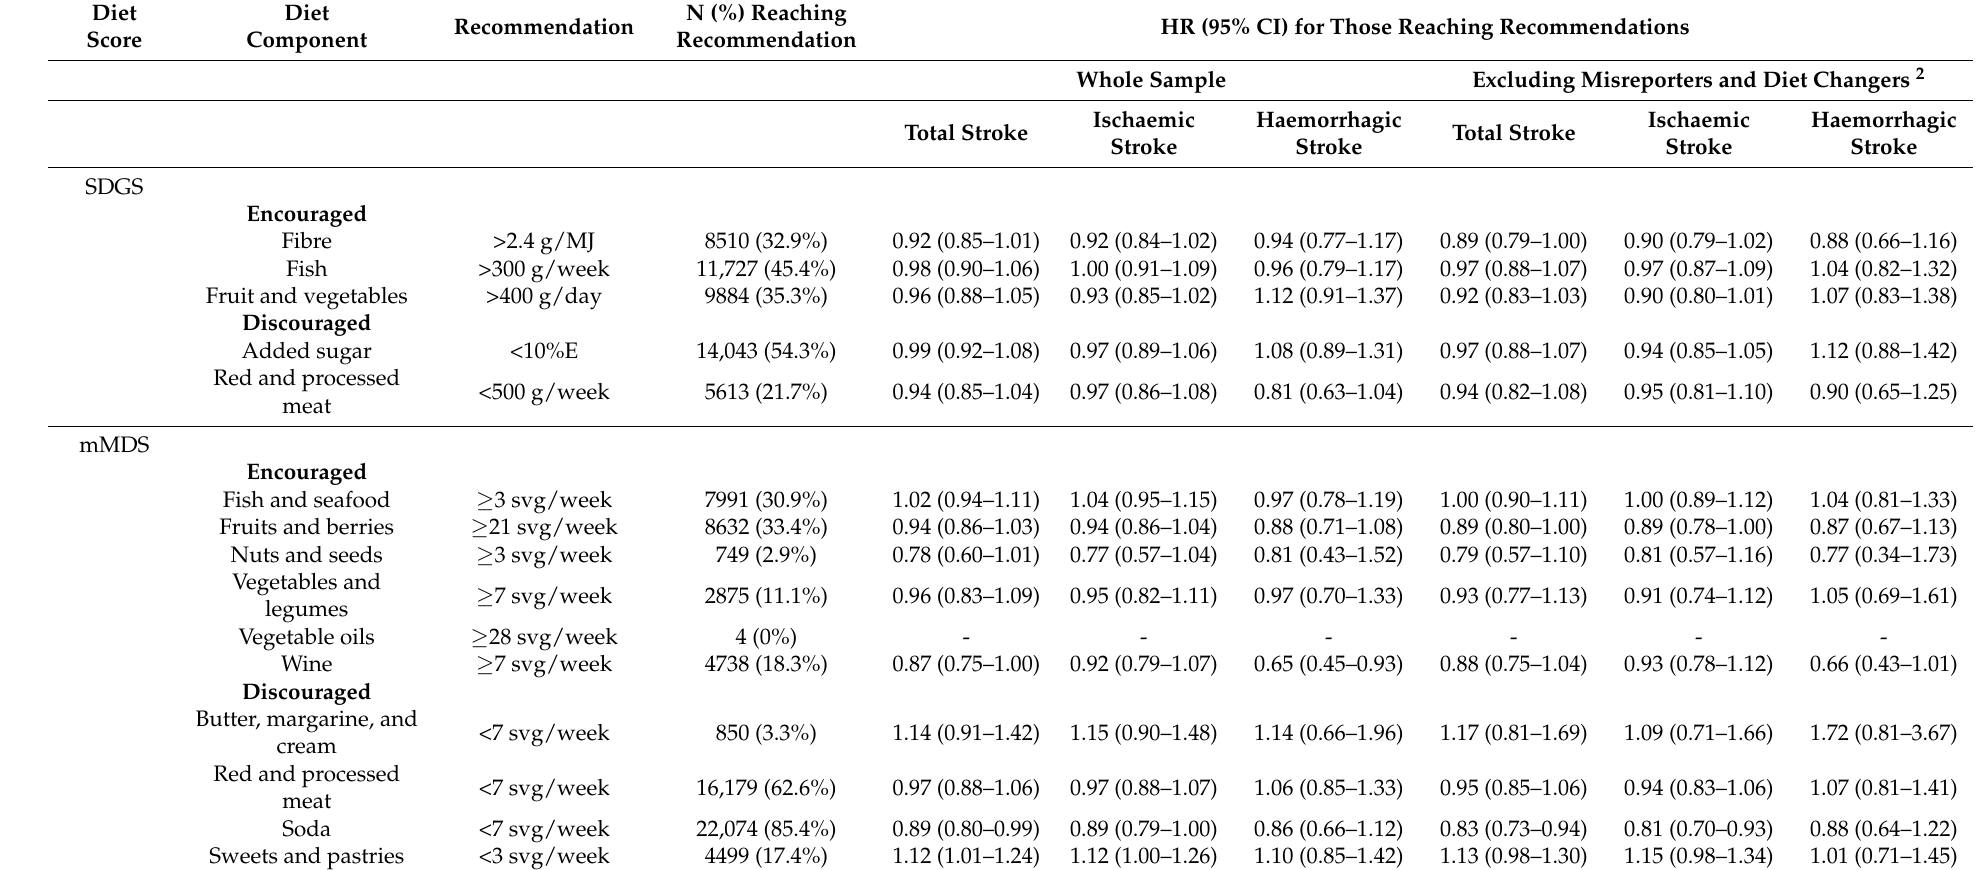
Table 5. Association (HR and 95% CI) between individual dietary components in the dietary scores and risk of stroke 1